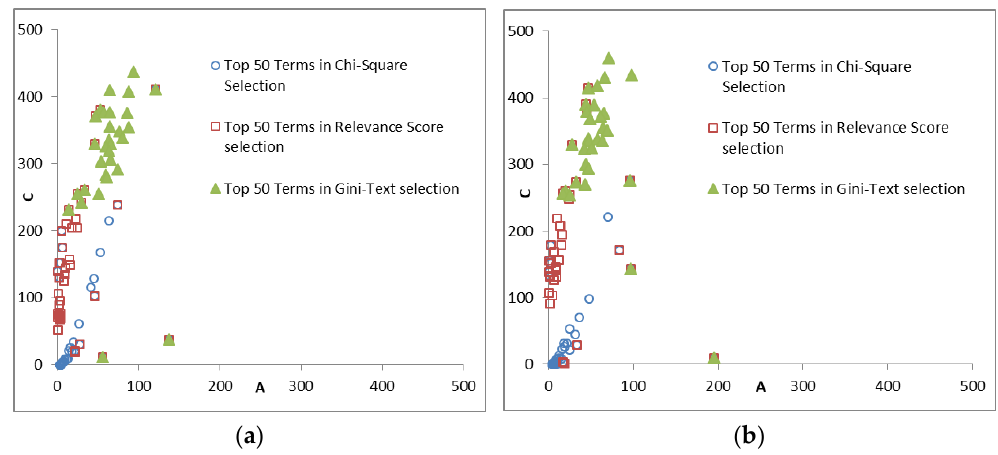
Figure 2. The topmost 50 terms in Chi-Square, Relevance Score, and Gini-Text selections. ( a ) Anger category, ( b ) disgust category. Table 4. Average (A), average (C), and average (A) / average (C) in the anger category using the topmost 50